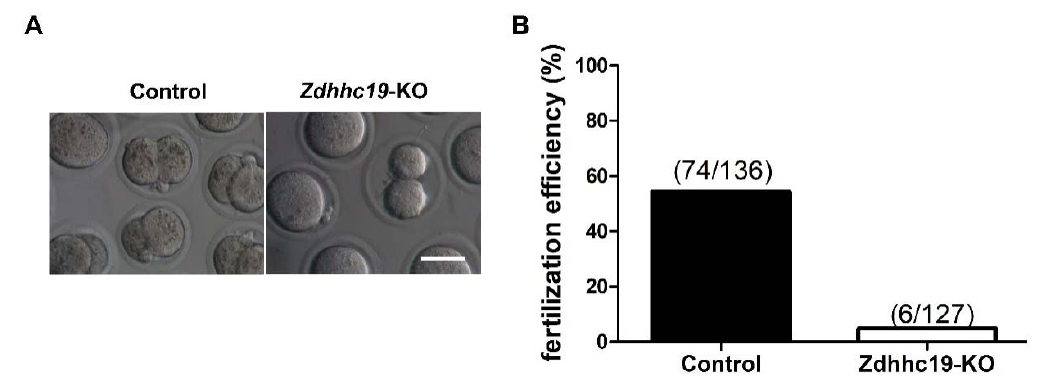
Figure 6. IVF analysis of Zdhhc19 KO spermatozoa. ( A ) Cumulus-intact eggs were incubated in vitro with capacitated Zdhhc19 KO or control sperm. Scale bar, 200 µ m. ( B ) The percentage of 2-cell stage embryos upon IVF with control or KO sperm were calculated.